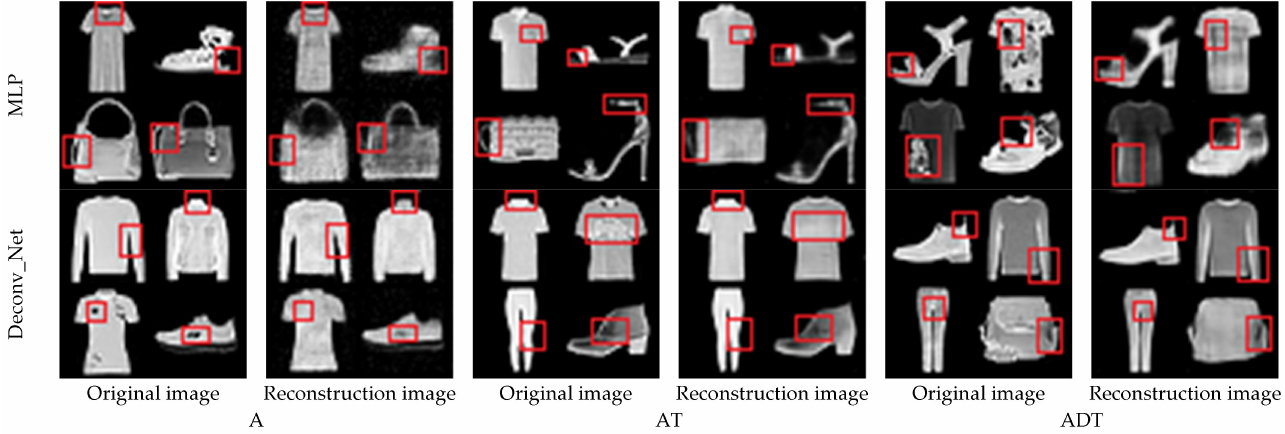
Figure 11. Reconstruction results of at a 95% compression